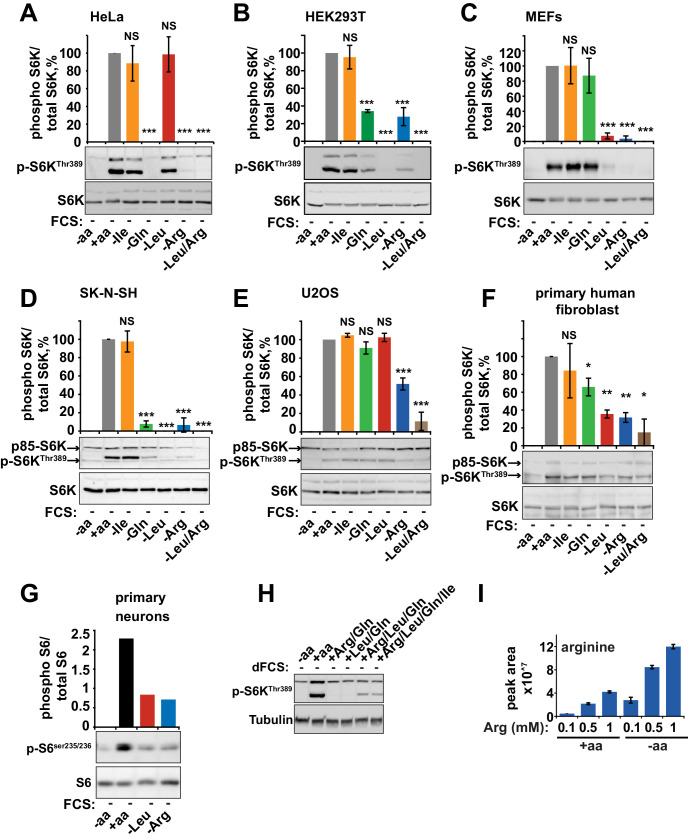
Arginine and leucine are important mediators of mTORC1 activity in a wide range of cells.HeLa (A), HEK293T (B), MEFs (C), SK-N-SH (D), U20S (E), primary human fibroblasts (MRC5, F), and primary mouse neurons (G) were starved of individual amino acids as indicated. Cell lysates were analyzed for phosphorylation of S6K and/or S6. (H) HeLa cells were incubated with amino acid mixtures as indicated. Cells lysates were analyzed by western blot for phosphorylation of S6K. (I) HeLa cells were cultured with the indicated concentrations of arginine either in the presence or absence of a complete set of amino acids. Cells were harvested and subjected to LC-MS to measure intracellular levels of arginine. All graphs with statistics represent an average of at least three independent experiments and error bars represent s.e.m. Graphs not displaying error bars are an average of at least two technical repeats. *p<0.05, **p<0.01, ***p<0.005. MEFs, mouse embryonic fibroblasts.